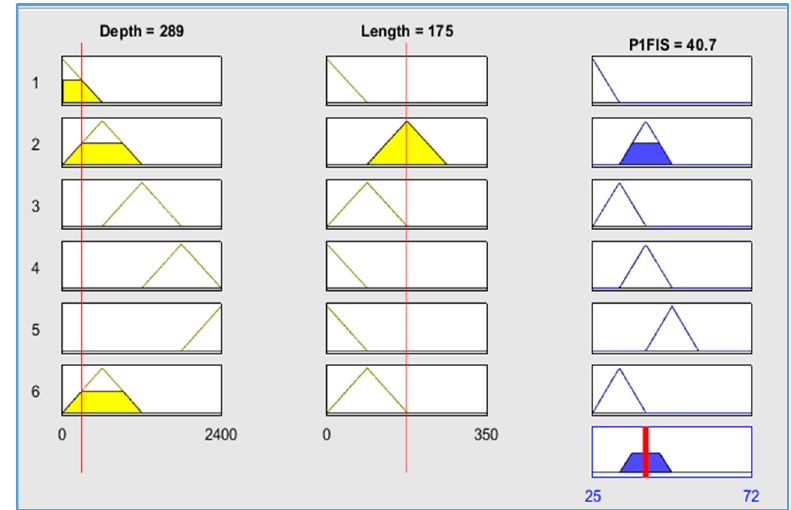
Figure 11. Example of fuzzy rules used in P 1 _FIS.